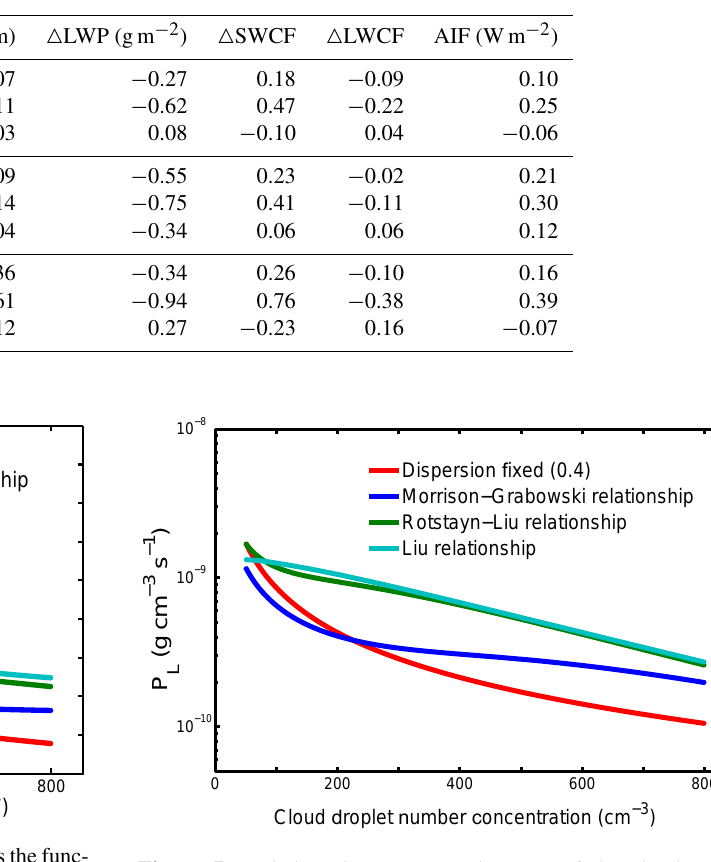
Figure 7. Variations in autoconversion rate of the cloud water mass content ( P L ) as the functions of droplet concentration for the fixed dispersion (0.4), the Morrison–Grabowski relationship, the Rotstayn–Liu relationship, and the Liu relationship ( L c is fixed as 1.4gm − 3